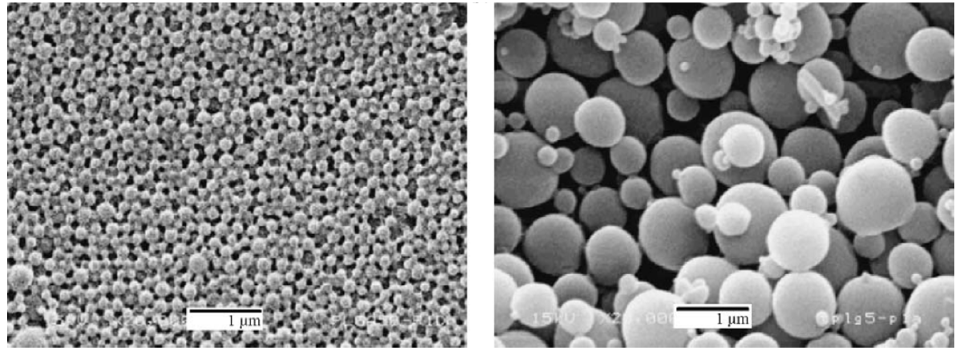
Figure 9. SEM images of PCM microcapsules: spray drying ( left ) and coacervation ( right ), Zhang et al. [115]. Reproduced with permission from Elsevier.